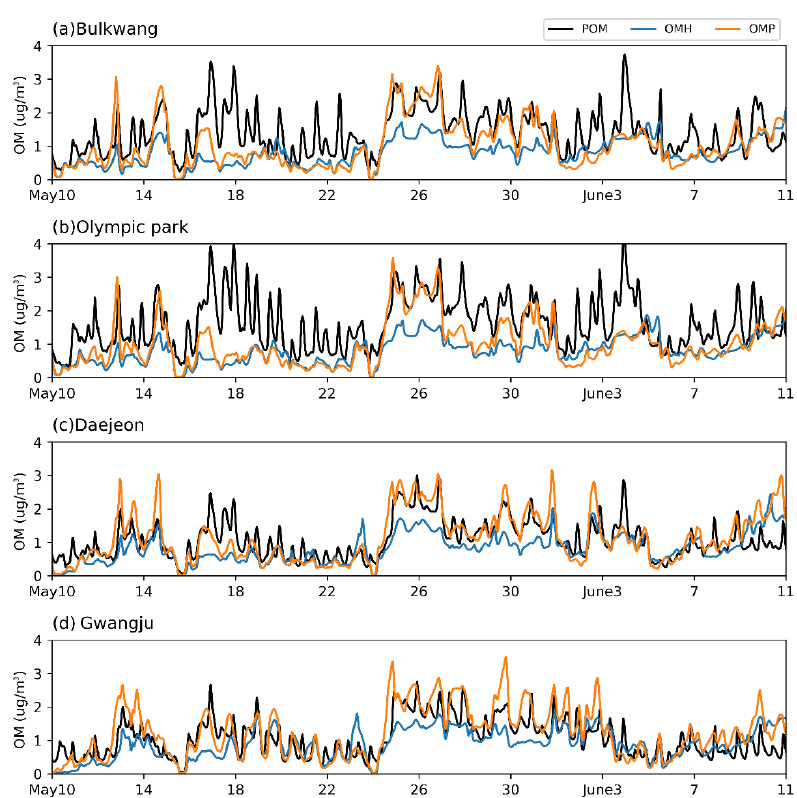
Figure 6. Time profiles of the predicted hourly averaged concentrations of primary organic matter (POM), OM formed via heterogeneous reactions (OMH), and OM formed via the gas–particle partitioning process at the (a) Bulkwang, (b) Olympic Park, (c) Daejeon, and (d) Gwangju